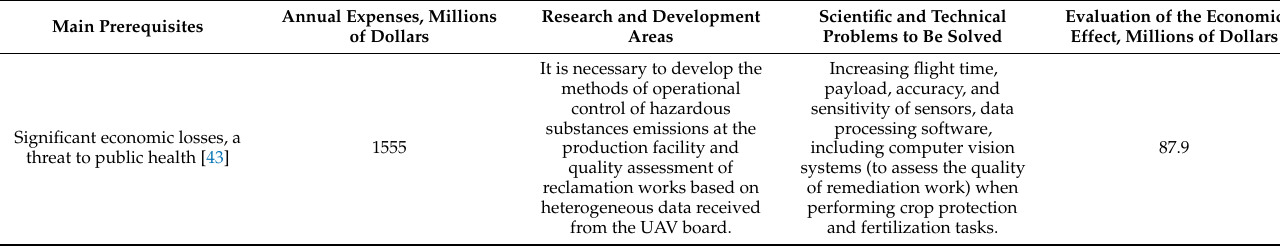
Table A3. IUAVT use for the environmental monitoring